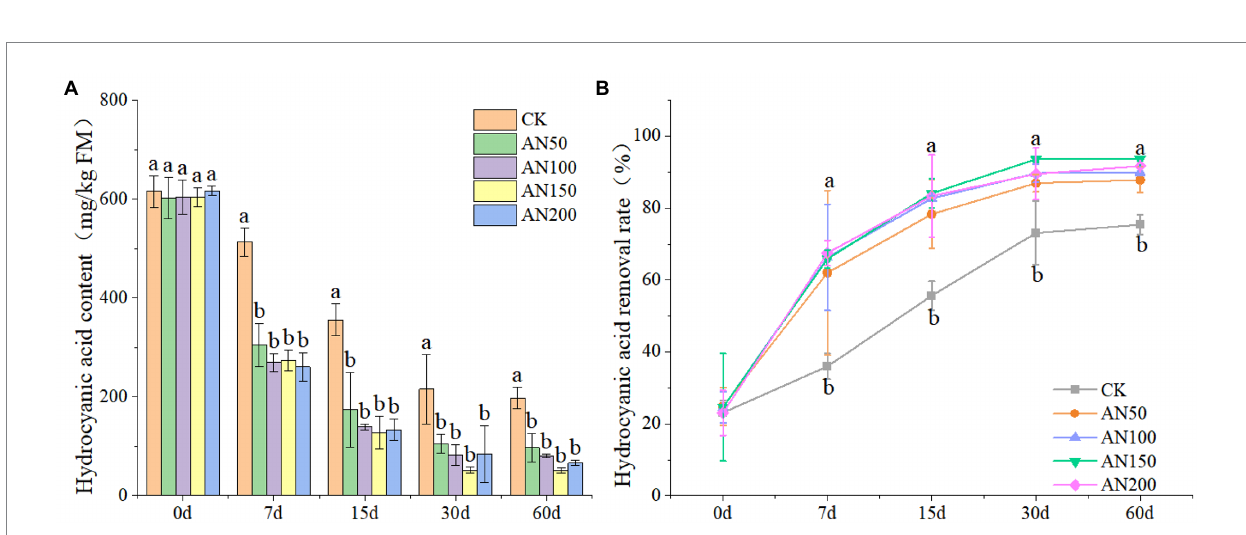
FIGURE 2 Hydrogen cyanide contents (A) and removal rates (B) of ratooning sorghum ensiled with different concentrations of A. niger . CK: 200 mL of sterile water per 3 kg of silage; AN50: 50 mL A. niger + 150 mL sterile water per 3 kg of silage; AN100:100 mL A. niger + 100 mL sterile water per 3 kg of silage; AN150: 150 mL A. niger + 50 ml sterile water per 3 kg of silage; AN200: 200 mL A. niger per 3 kg of silage. Different lowercase letter above the data bar represented significance between concentrations of A. niger within same fermentation time at p <